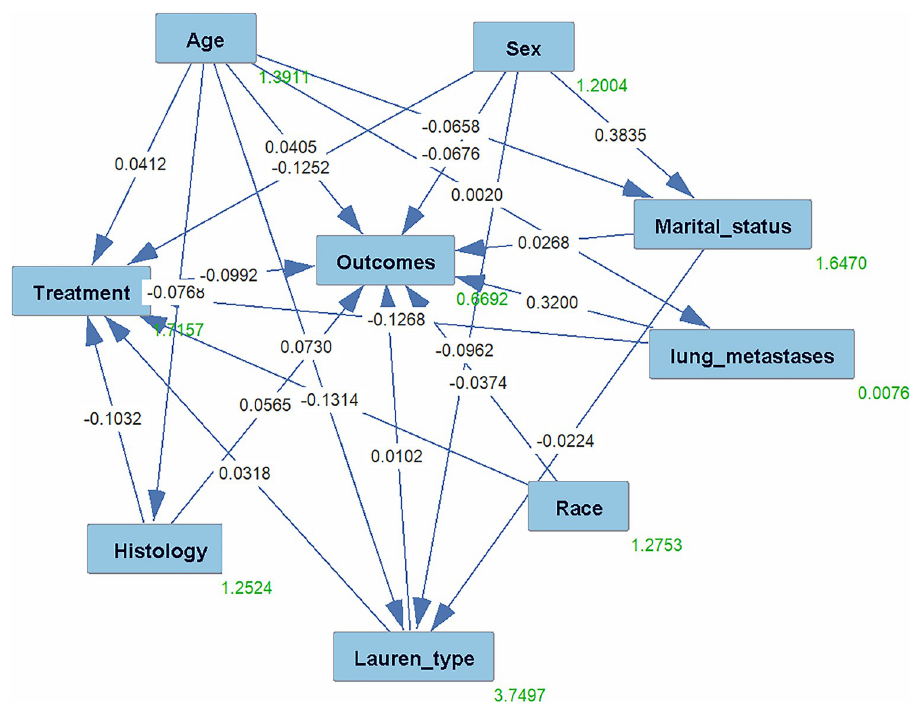
Fig 3. Directed acyclic graphs are derived from literature and expert knowledge. Nodes represent variables and arrows represent causal associations between variables. The Dark-colored nodes represent the factors affecting gastric cancer.